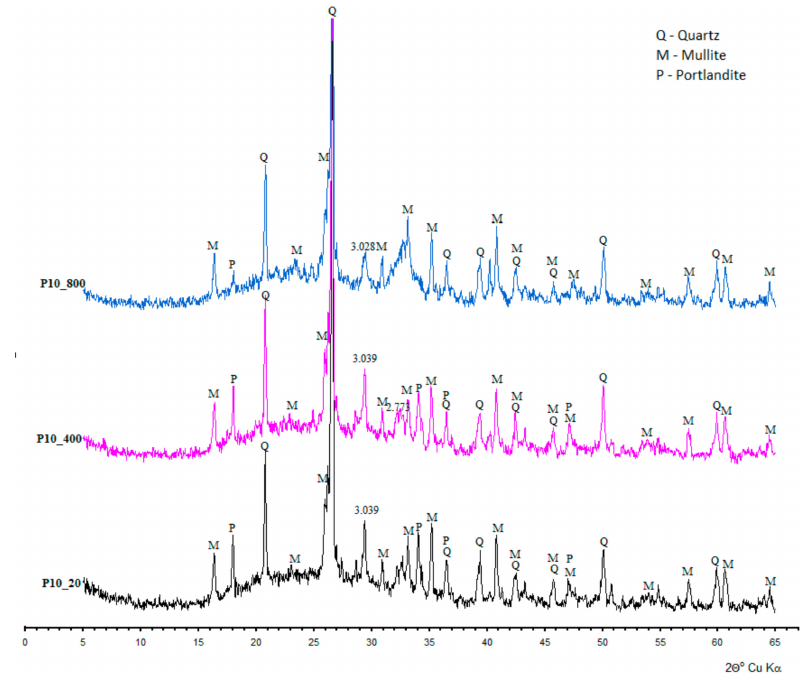
Figure 6. Diffractogram of mineral content of studied concretes containing Portland cement.